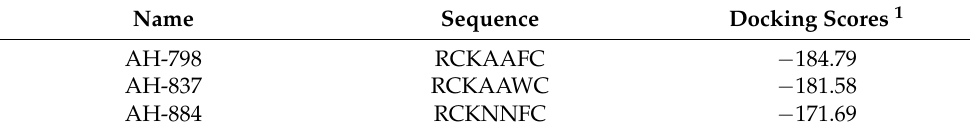
Table 2. Comparison of docking scores of selected sequences calculated by